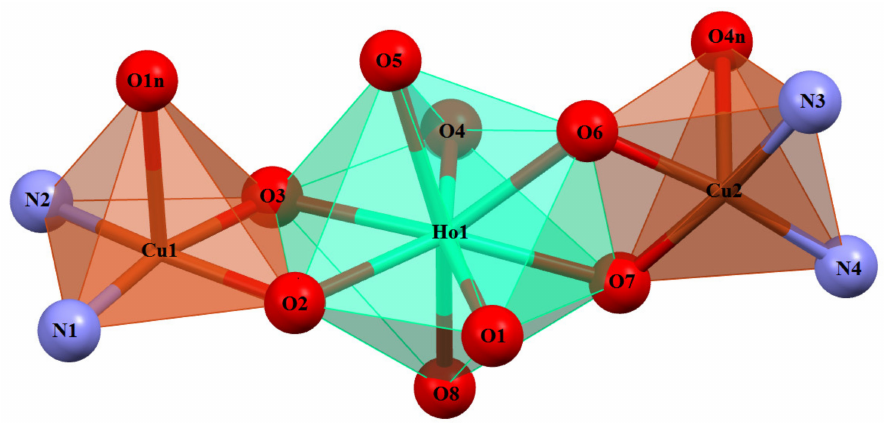
Figure 5. Coordination polyhedra of Cu(II) and Ho(III) cations in the trinuclear complex 1